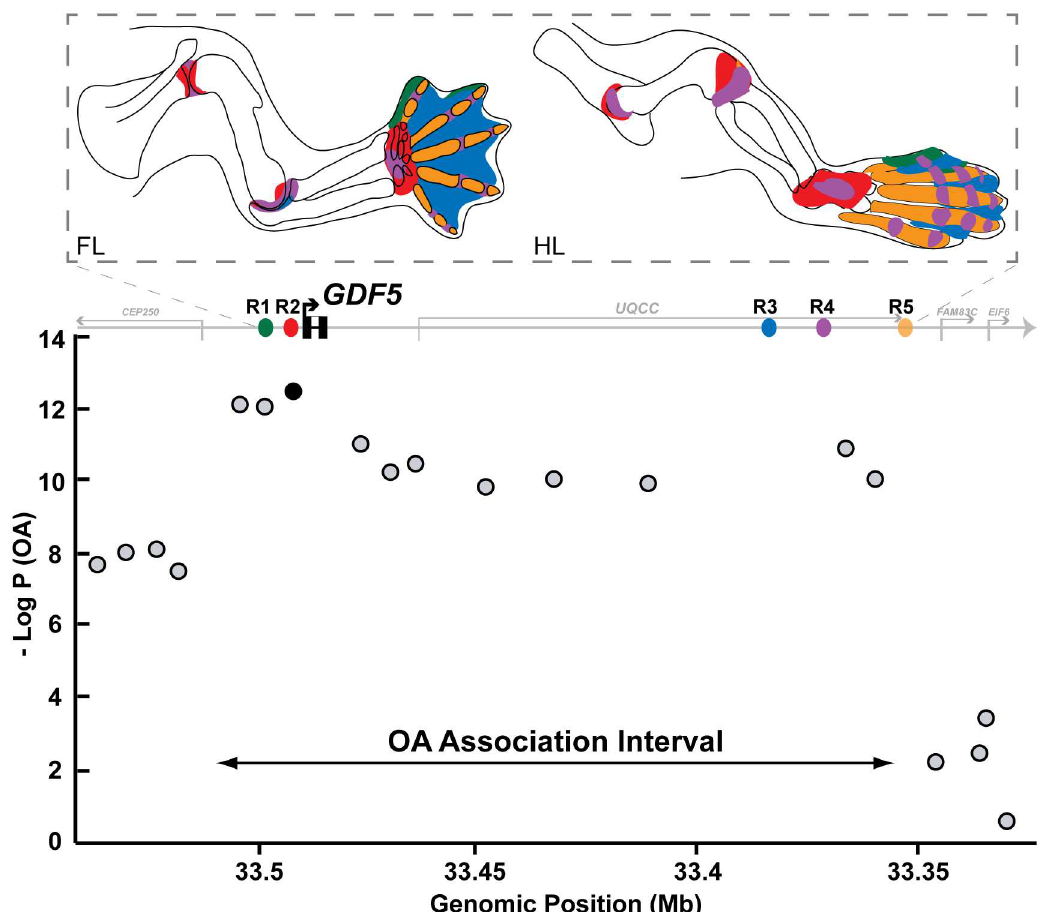
Fig 6. Modular regulatory architecture of GDF5 spans the region linked to Osteoarthritis (OA) susceptibility in humans. (Top) Summary of the different stripes and anatomicaldomainscontrolled by separateregulatoryenhancers (colored)in the Gdf5 gene in E14.5 developingmouse forelimbs (FL) and hindlimbs (HL). (Bottom) Associationof various humanSNPs (grey circles) with adult knee OA in cases vs. controls (based on [27]). Y-axis is the -log P-value of the trait associationfor SNPs across the interval. X-axes show genomicmegabaselocations(bottom axis) of human sequencesorthologousto R1 (green), R2 (red), R3 (blue), R4 (purple),and R5 (orange) elements(top axis). The highest scoring variant tested in the humanstudy, rs143383 (dark circle), is locatedin GDF5 5’UTR, immediately downstream of the R2 region. Note that significantassociationextends over a broad region, and many linked humanvariants have not yet been tested, including common humanvariants in R2, R3, R4, and R5 (see S4